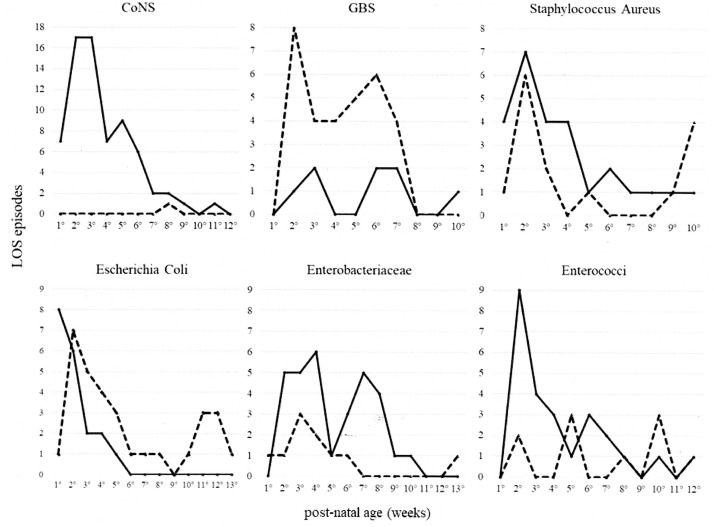
Pathogens according to age at presentation in hospital- and community-acquired LOS.CoNS, coagulase-negative staphylococci; GBS, group B streptococcus. Continuous line, hospital-acquired LOS. Dashed line, community-acquired LOS.